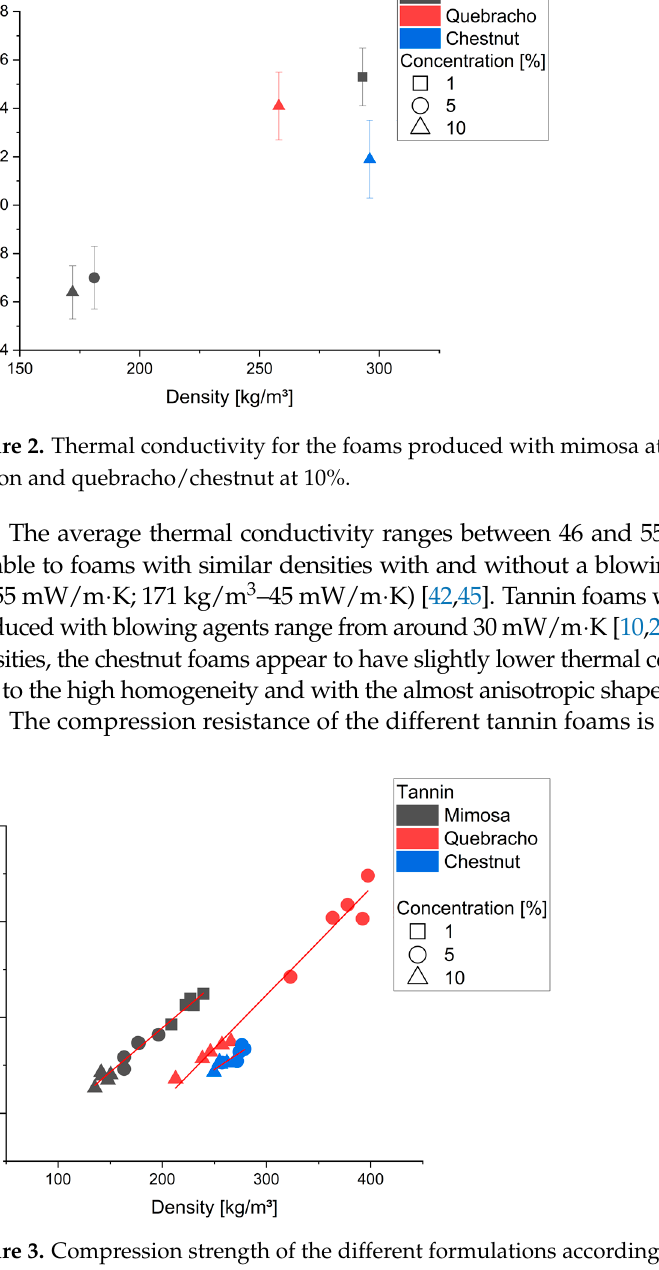
Table 2. Literature comparison of tannin-based foams with densities between 90 to 350 kg/m 3 . Foam Formulation